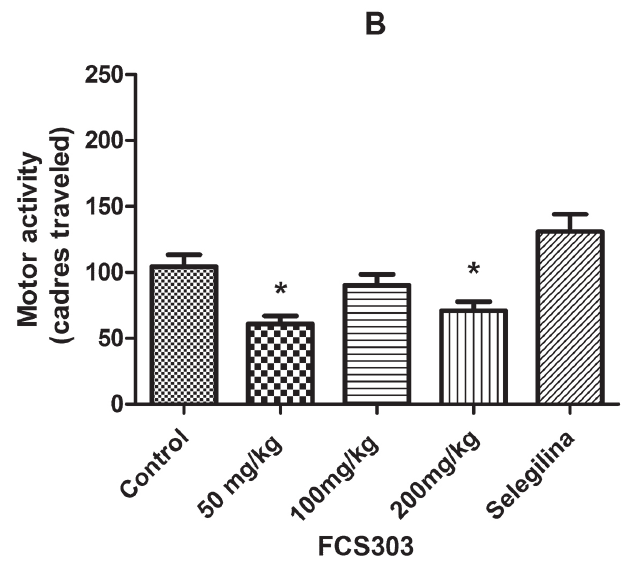
FIGURE 2B - Effect of administration of FCS303 (50, 100, and 200 mg/kg), control (vehicle 0.1 mL/10 g body weight), or selegiline (10 mg/kg) on motor activity in non-reserpinized mice. The animals were observed in an open-field test at 23.5 h after administration of compound FCS303. n = 7–9. *p < 0.05 compared to the control group.